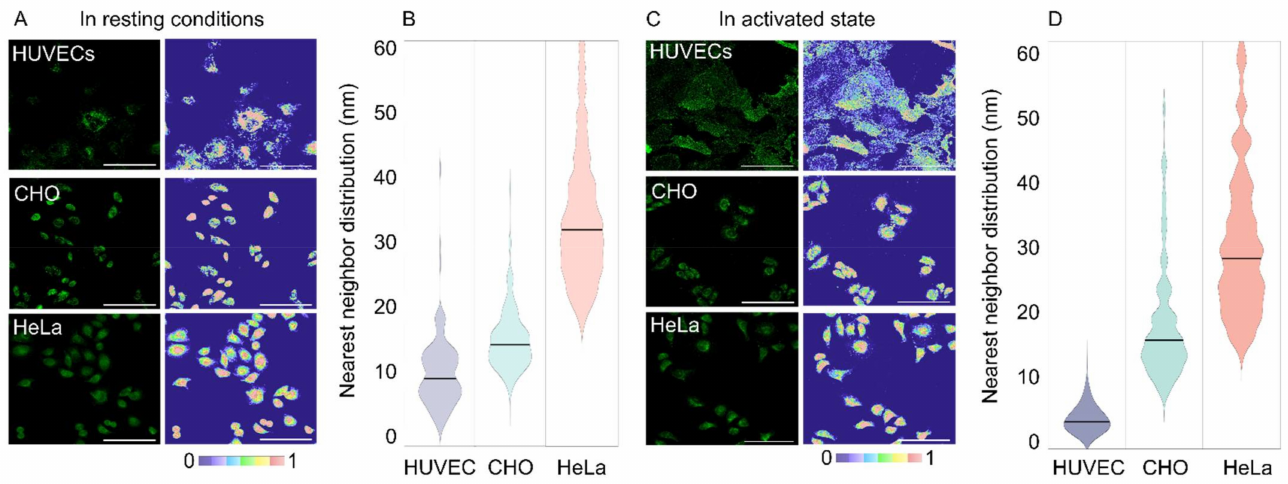
Figure 3. α 5 β 1 expression and distribution in HUVEC, CHO, and HeLa cells. ( A ) Representative fluorescent microscopy images and their projected integrin density heatmap for resting conditions. ( B ) Global integrin nearest neighbor distributions across cell types in resting conditions. Horizontal lines represent the median values. ( C , D ) similar to ( A , B ) for integrins in their activated state. Scale bar = 100 µ